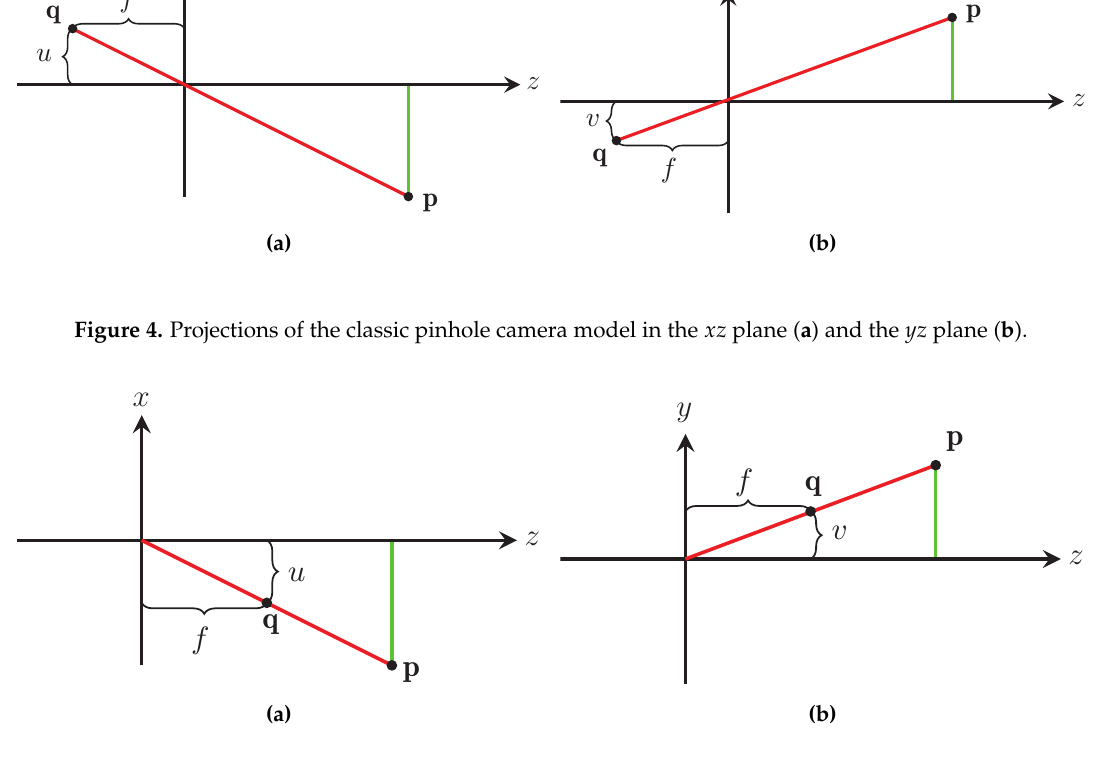
Figure 5. Projections of the modified pinhole camera model in the xz plane ( a ) and the yz plane ( b